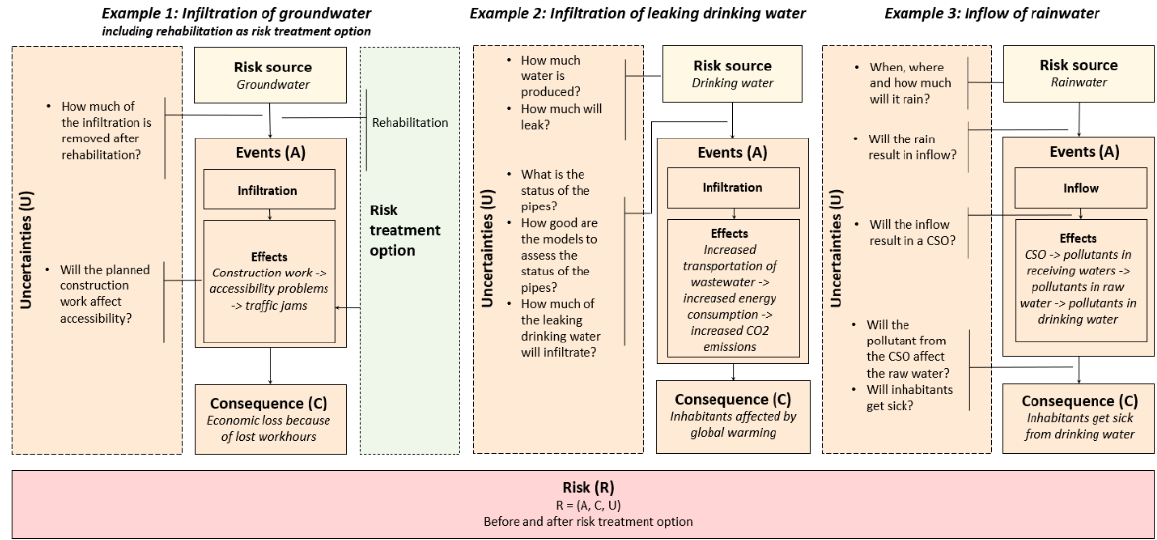
Figure 5. Examples of risk sources, events, and consequences with corresponding uncertainties. In the figure, the consequences are formulated from a utilitarian perspective, i.e., depending on how humans are affected.